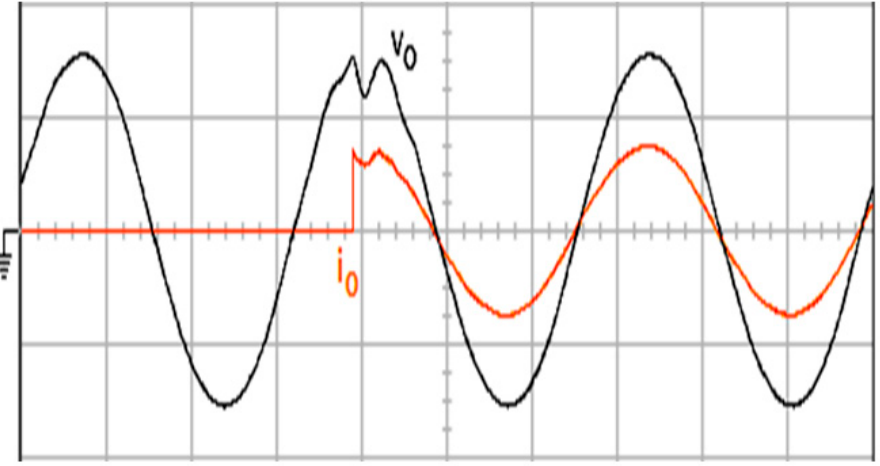
Figure 10. Experimental waveforms under a step change in load for classic FTCC (100 V/div; 20 A/div; 5 ms/div).